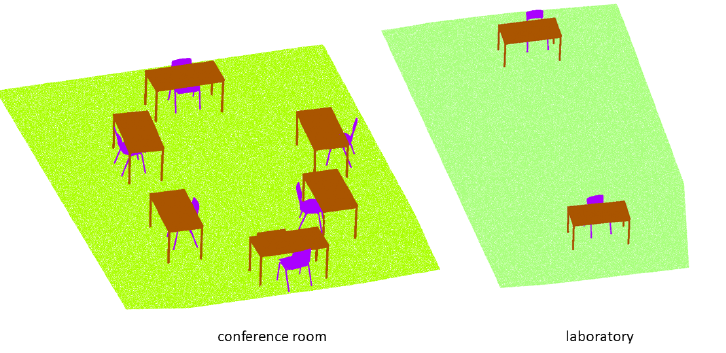
Figure 12. GT point cloud for determination and verification of correctness and precision